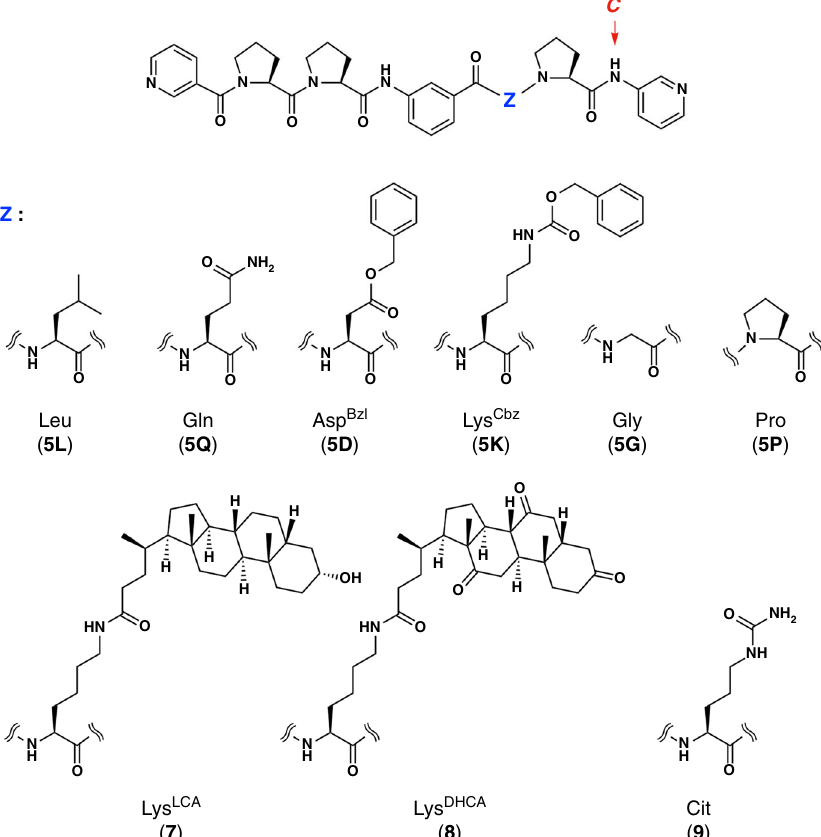
Fig. 5 Peptide ligands with various residues at the Z position. Chemical structures of peptide ligands 5L , 5Q , 5D , 5K , 5G , 5P , 7 , 8 and 9 .